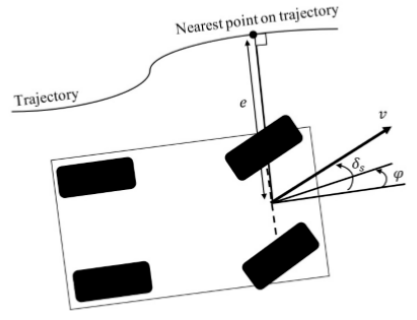
Figure 4. Stanley’s configuration.